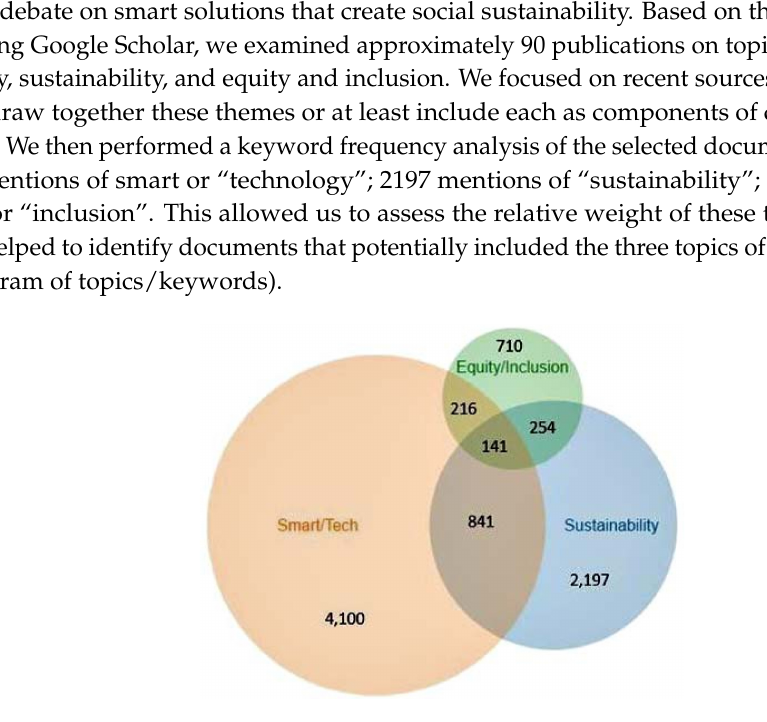
Figure 1. Document analysis and keyword co-mentions (note: numbers show the frequency of